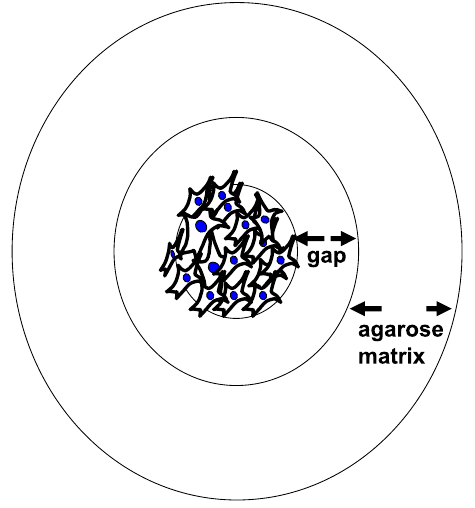
Fig. 2. Novel chemoattractant assay. Schematic of the novel chemoattractant assay showing a centrally placed 10 mm coverslip with confluent AY-27 cells surrounded by a 1 mm gap. An agarose matrix on the periphery of the 12 mm tissue culture well contained RPMI supplemented with 50%